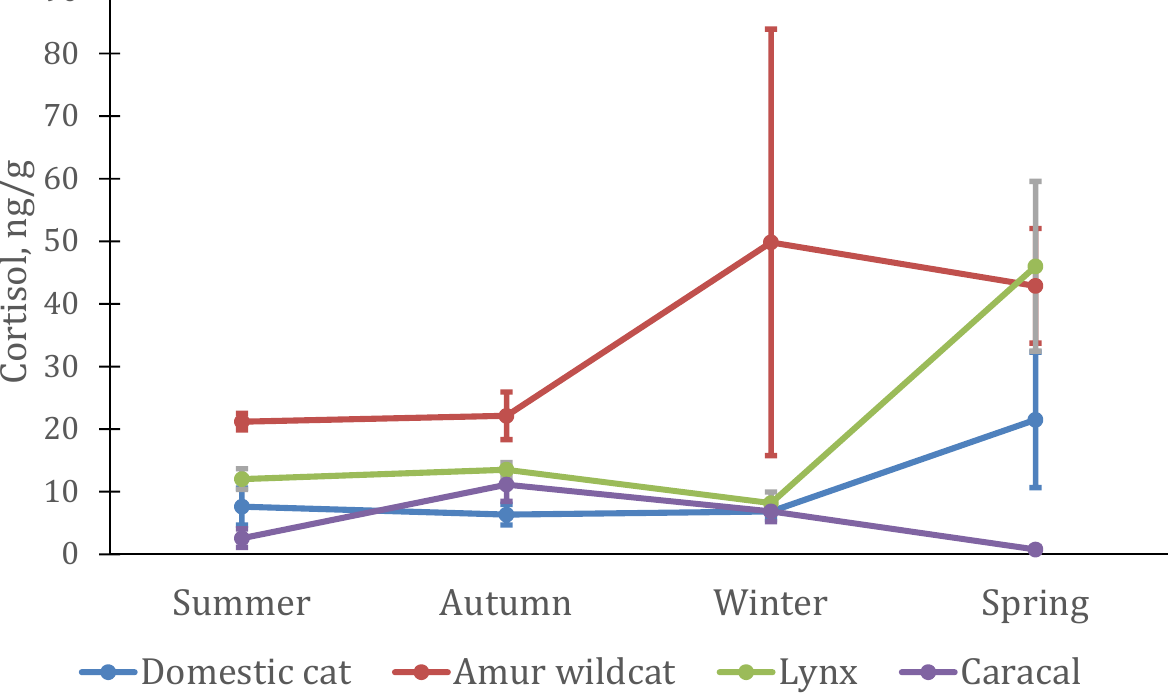
Figure 5. Cortisol concentration in hairs from four male felid species ( n = 5 domestic cats, n = 4 lynx, n = 4 Amur wildcats, n = 4 caracals).